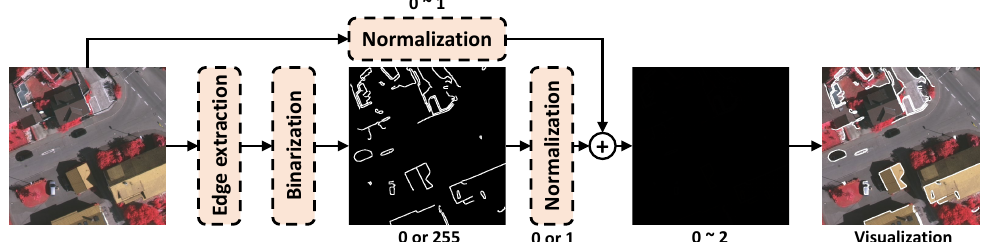
Figure 8. Detailed structure of explicit edge enhancement method.